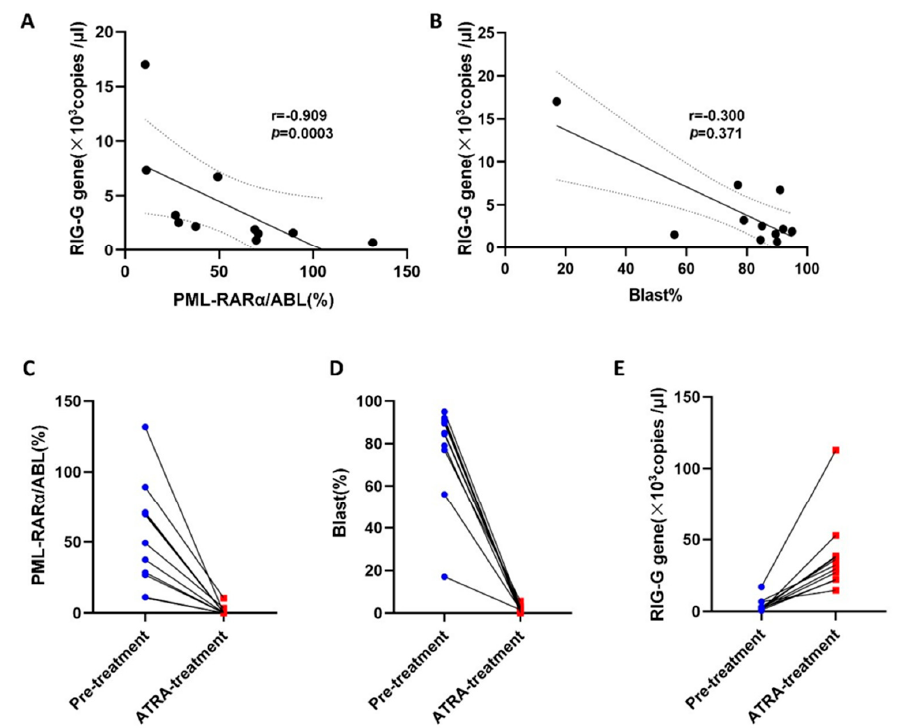
Figure 5. Correlation of RIG-G gene expression with PML-RAR α fusion gene and blast cells in APL. ( A ) RIG-G gene expression and PML-RAR α /ABL (%) were highly negatively correlated before ATRA treatment ( n = 11, r = − 0.909, p = 0.0003).( B ) RIG-G gene expression and Blast (%) were slightly negatively correlated before ATRA treatment ( n = 11, r = − 0.300, p = 0.371). ( C – E ) PML-RAR α /ABL (%) and Blast (%) decreased significantly after ATRA treatment ( p < 0.0001), meanwhile, the expression level of RIG-G gene increased significantly ( p = 0.0004) in APL